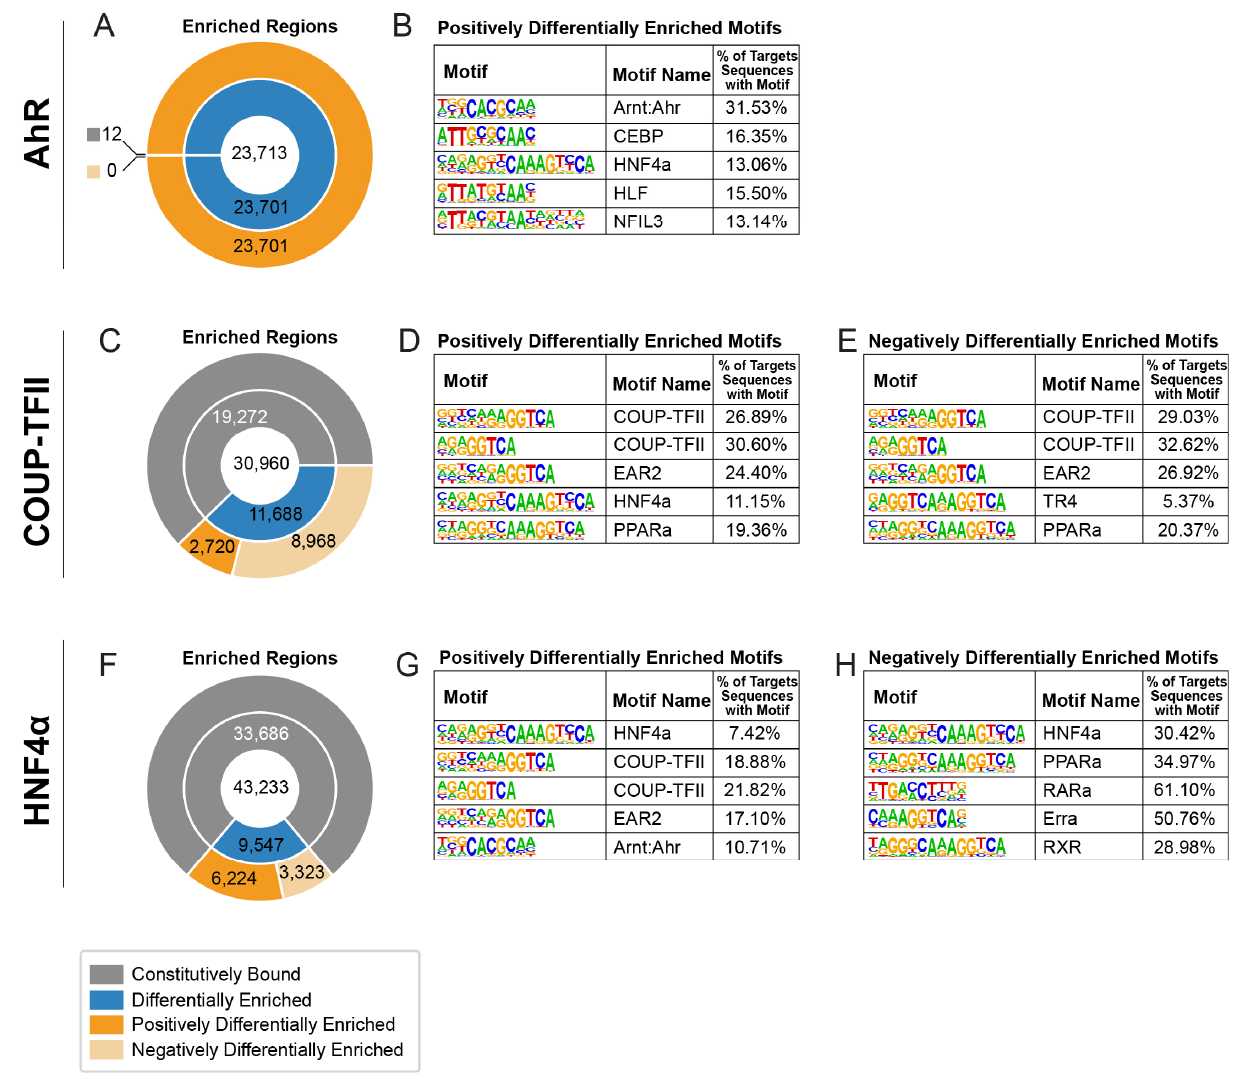
Figure 2. Over-represented motif analysis within differentially enriched peak sequences. ( A , C , F ) The effect of TCDD on the total number of enriched regions (center of donut plots) for AhR, COUP-TFII and HNF4 α (0.6 ≥ fold-change ≥ 1.5; blue regions). Differentially enriched regions were further assessed for increased (positive—increased binding) and decreased (negative—decreased binding) enrichment (shades of orange). Sequences within positive ( B , D , G ) and negative ( E , H ) differentially enriched regions for each transcription factor were analyzed for enriched DNA motifs. The top 5 binding motifs ranked by p-value for each group are depicted. All over-represented motifs identified are listed in Supplementary File